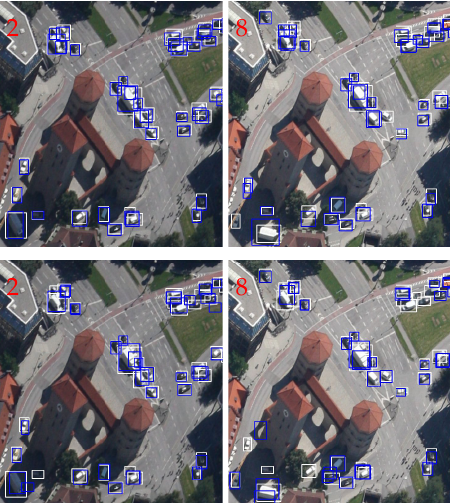
Figure 19. Tracking results by AerialMPTNet (top row) and SMSOT-CNN (bottom row) on the frames 2 and 8 of the “MunichCrossroad02” sequence of the KIT AIS vehicle dataset. The predictions and ground truth bounding boxes are depicted in blue and white, respectively.